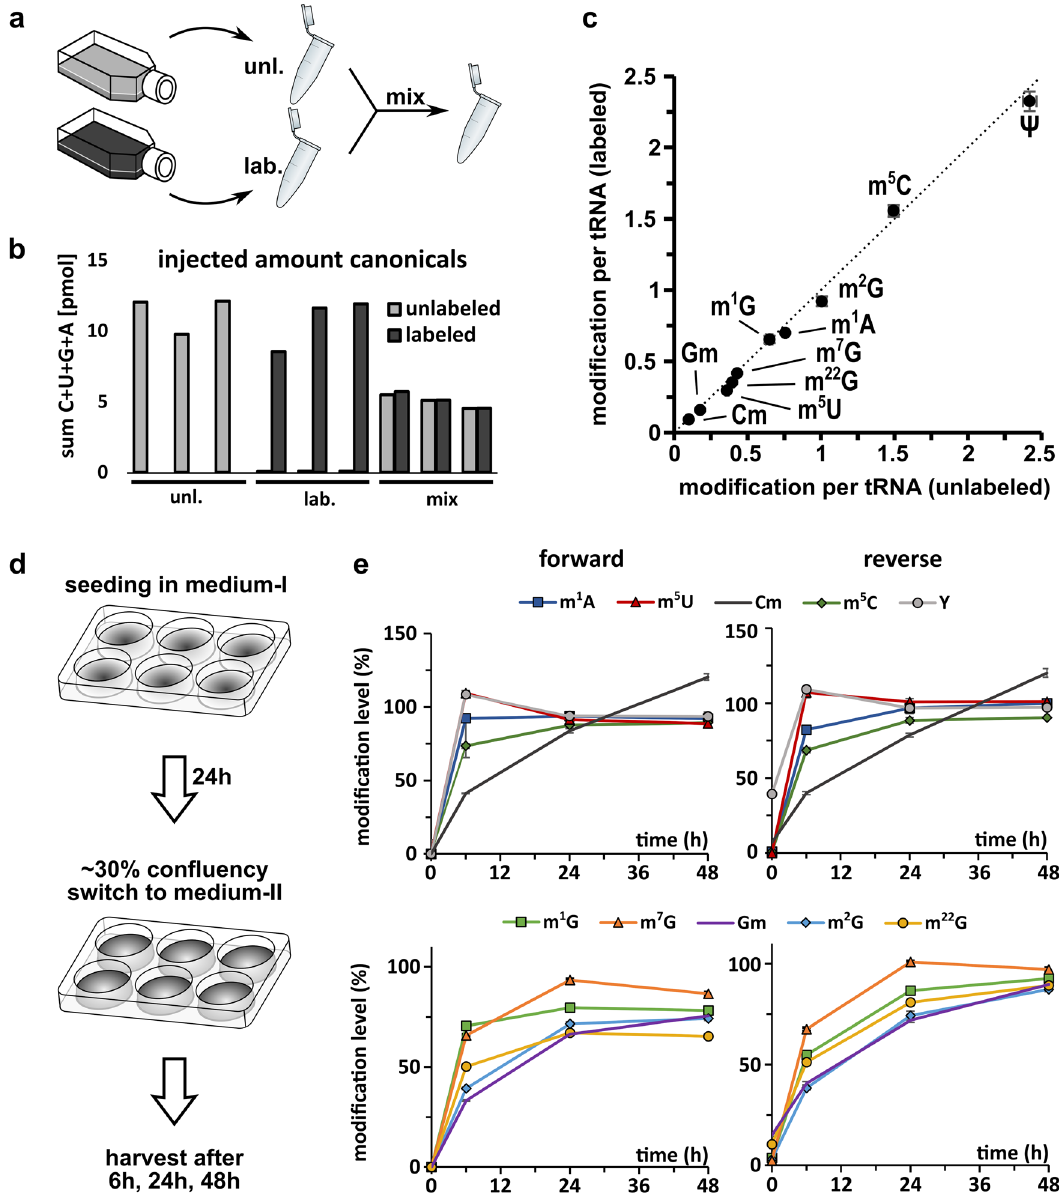
Fig. 3 Validation of cell culture NAIL-MS. a Cells were grown in unlabeled or fully labeled media for 7 days. Upon harvesting one aliquot was mixed prior to processing (mix). Total tRNA was puri fi ed and all samples were analyzed by LC-MS/MS. b Summed amount of canonical nucleosides (C + U + G + A) detected by LC-MS/MS for unlabeled and labeled isotopologues. The bars show single replicates of three unlabeled, three labeled and three mixed aliquots. c Abundance of labeled modi fi cations plotted against the abundance of unlabeled modi fi cations in the mix samples. The dotted line indicates the location of the expected values as a visual guide. d Experimental setup of time course study to investigate temporal placement of RNA modi fi cations. The experiment was done forward (start with unlabeled, change to labeled medium) and reverse (vice versa). e Results of time course study. Plotted on the y - axis is the abundance of modi fi cation in new transcripts normalized to the abundance before experiment initiation (T = 0). Note: In the reverse experiment, minor signals of unlabeled nucleosides are present at T = 0 and thus the starting value is sometimes larger than 0%. All experiments were done with puri fi ed total tRNA and are from n = 3 biol. replicates. Symbols re fl ect the mean and error bars re fl ect standard